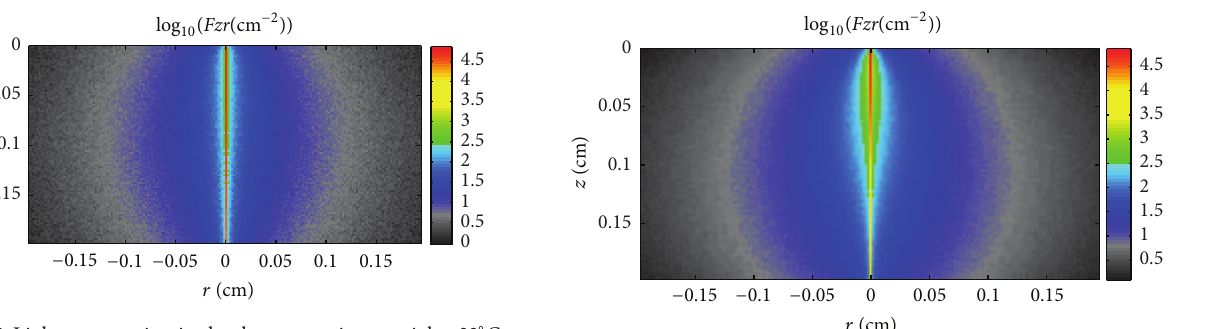
Figure 5: Light propagation in the thermotropic material at 32 ∘ C at the wavelength of 500 nm.